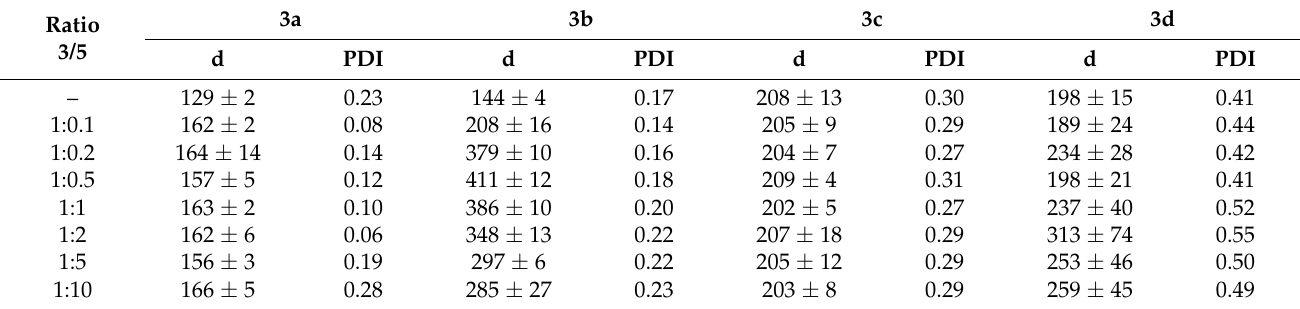
Table 2. Sizes of aggregates (average hydrodynamic diameter) of compounds 3a – d (1 × 10 − 4 M) in water in the presence and in the absence of pillar[5]arene 5 , obtained by the DLS